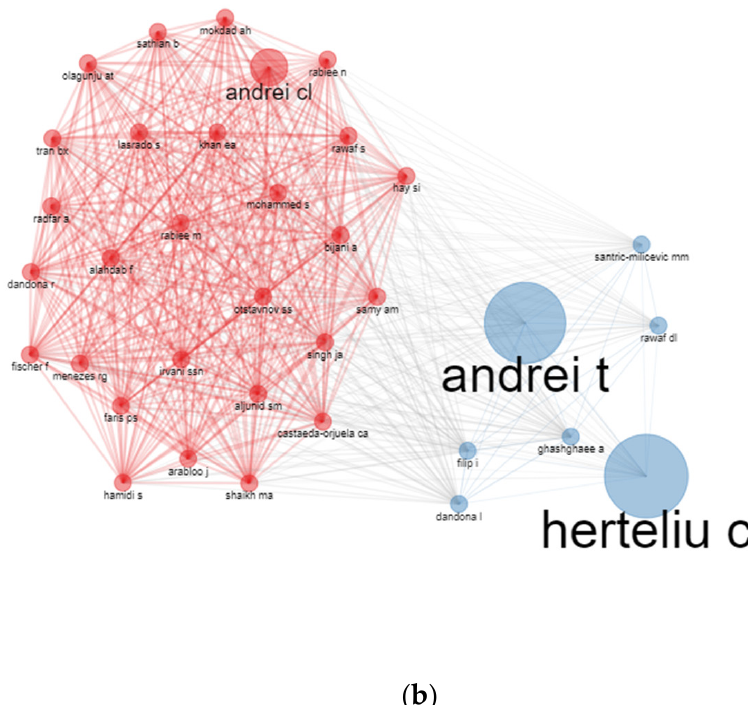
Figure 9. Authors’ clustering by coupling. ( a ) WoS. ( b ) Scopus.